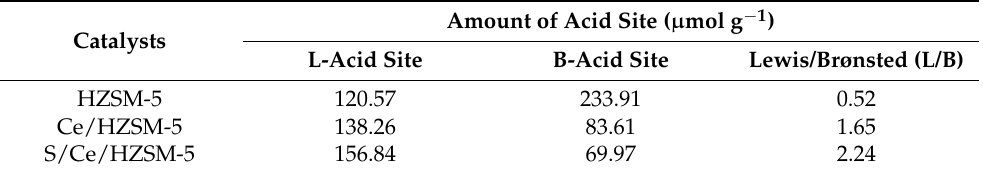
Figure 4. FT-IR spectra of pyridine adsorption on catalysts. Table 3. FT-IR spectra of pyridine adsorption results for the catalyst.